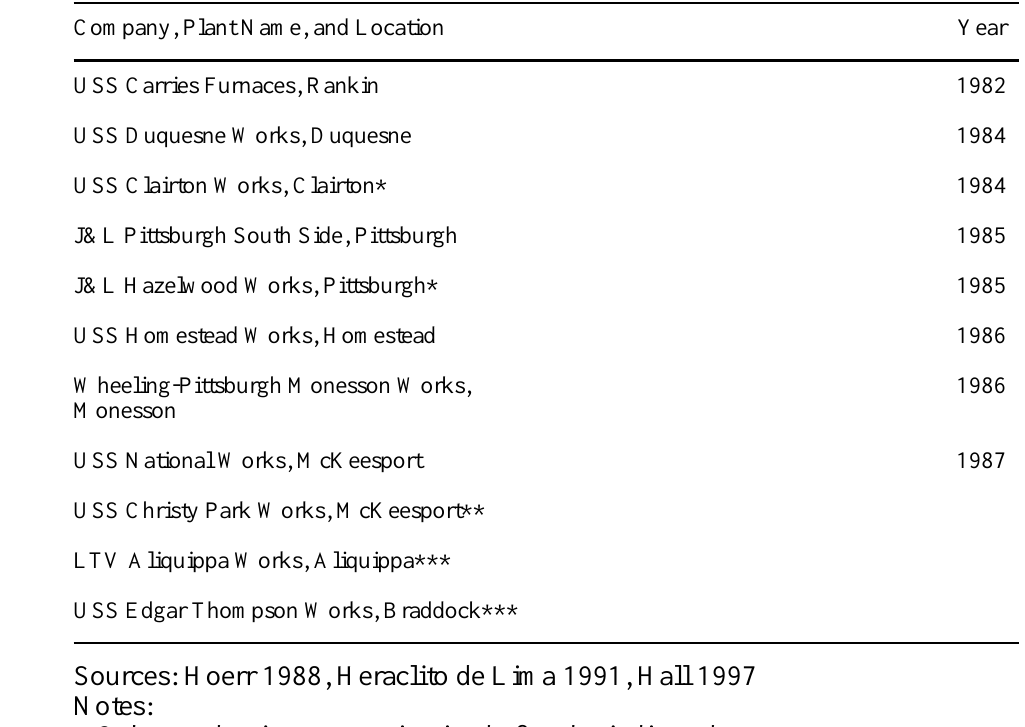
Table 2. Integrated steel plant closures in the Pittsburgh region since 1982 Company, Plant Name, and